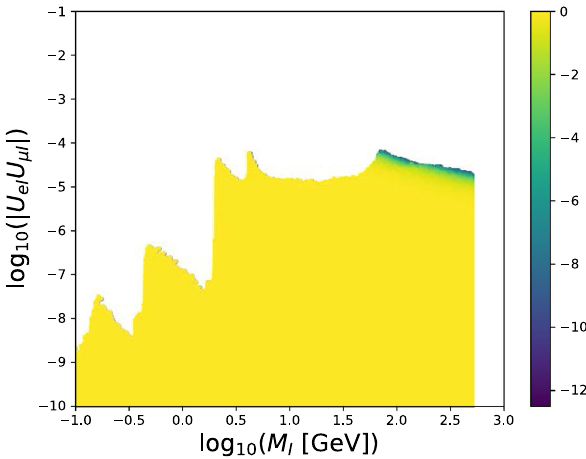
Fig. 34 Partial likelihood from lepton flavour violating decays μ →